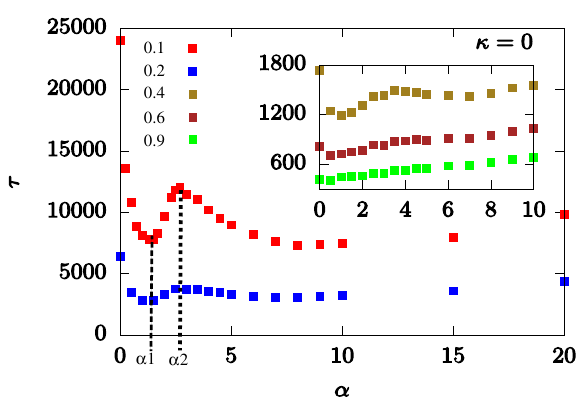
Figure 6. Total translocation time ( τ ) of flexible polymer as a function of apex angle ( α ) for different external forces f 0 . (Inset) Magnified plot of τ versus α at larger force values showing the disappearance of maxima- minima